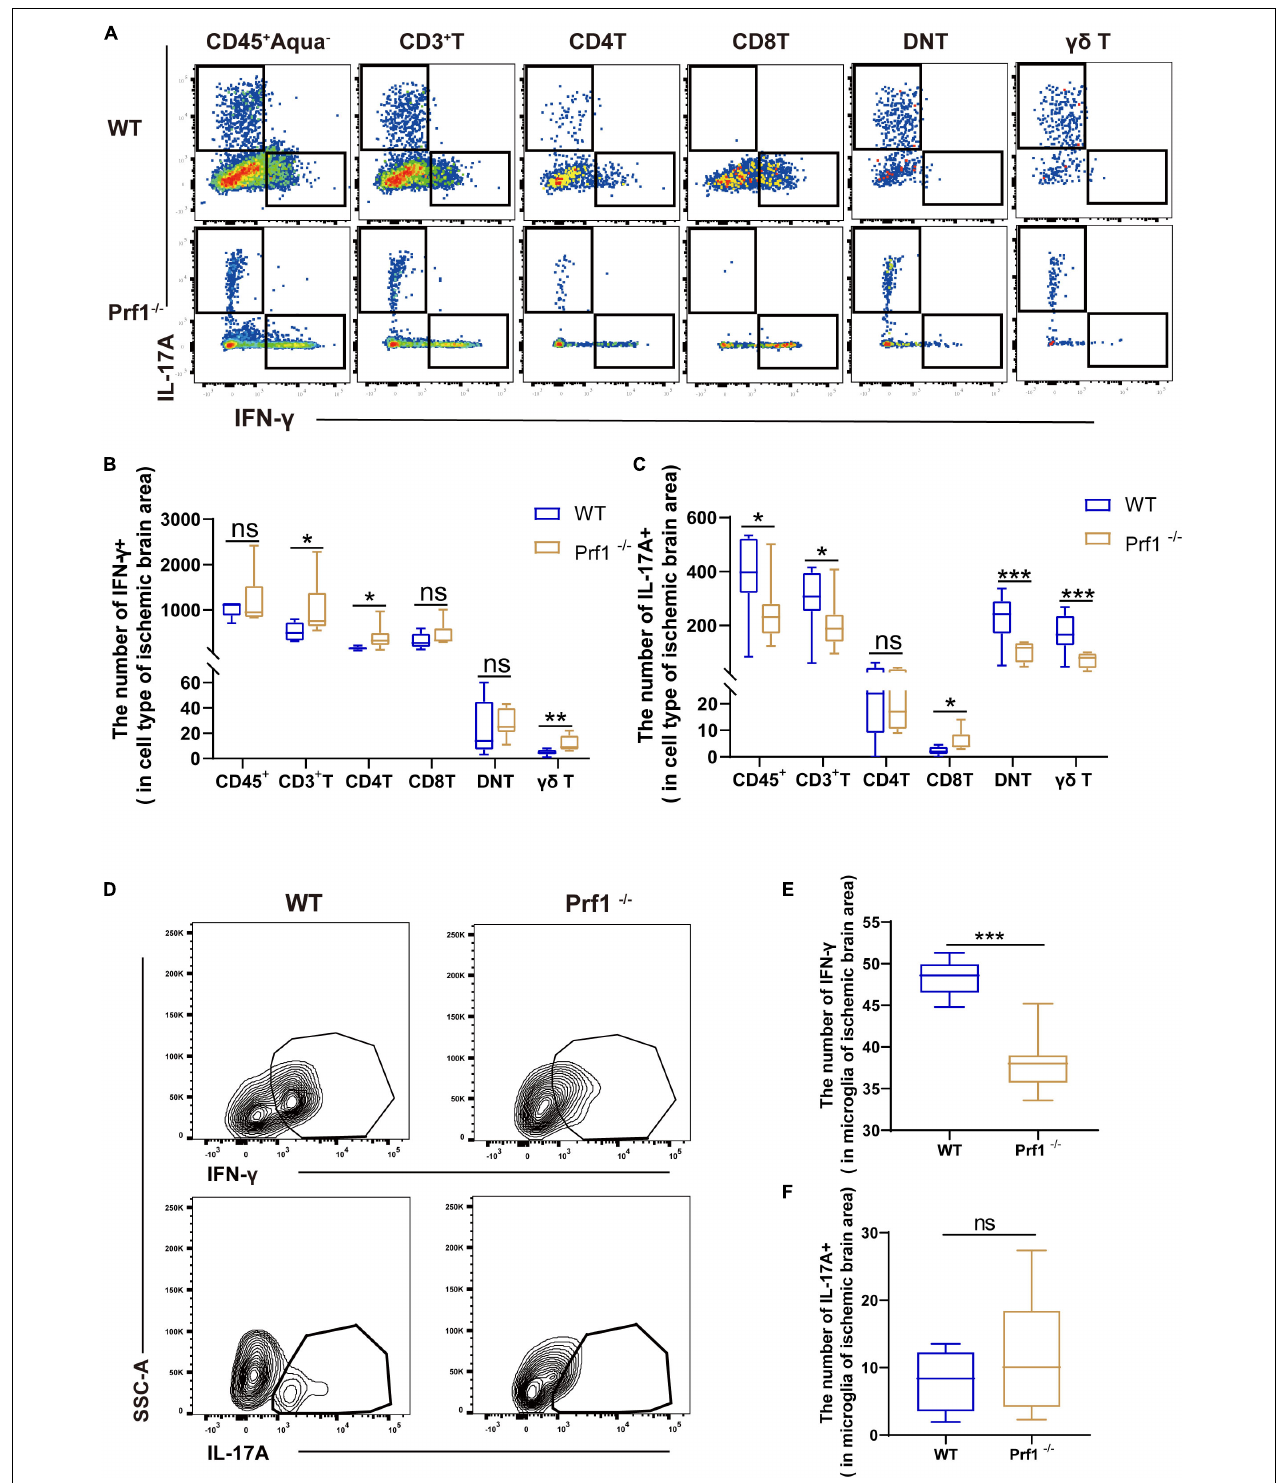
FIGURE 6 | Inhibition of perforin modulates the secretion of IFN- γ and IL-17 after ischemic stroke (A) The pseudocolor flow plot reveals the expression of IFN- γ and IL-17 in the ischemic brain area 14 days after dMCAO. (B,C) This statistical chart shows the expression levels of IL-17A or IFN- γ in various cells. (D) The contour map shows the secretion of IFN- γ and IL-17 from CD11b + CD45 low microglia in Prf1 - / - mice compared to WT mice. (E,F) The box chart shows the differences in cytokine secretion from microglia between Prf1 - / - and wild-type mice after dMCAO. The data are shown as the median and the value of min to max; n = (6–10) animals in each group. Prf1 - / - mice vs. WT mice at each time point. * P < 0.05, ** P < 0.01, *** P < 0.001.